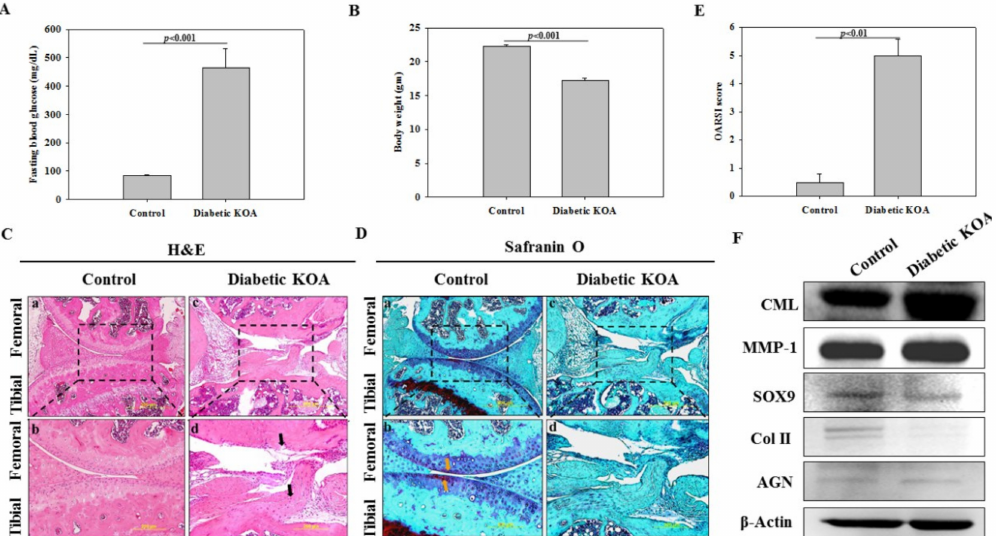
Figure 2. Characterization of KOA in diabetic mice after 4 weeks of STZ administration. Comparison of ( A ) blood glucose levels and ( B ) body weight. ( C ) H&E, and ( D ) safranin O staining for assessment of structure and distribution of red-colored proteoglycans (indicated by yellow arrows), respectively. Bar: 500 µ m (lower magnification, 10 × ), 200 µ m (higher magnification, 20 × ). ( E ) OARSI grade for